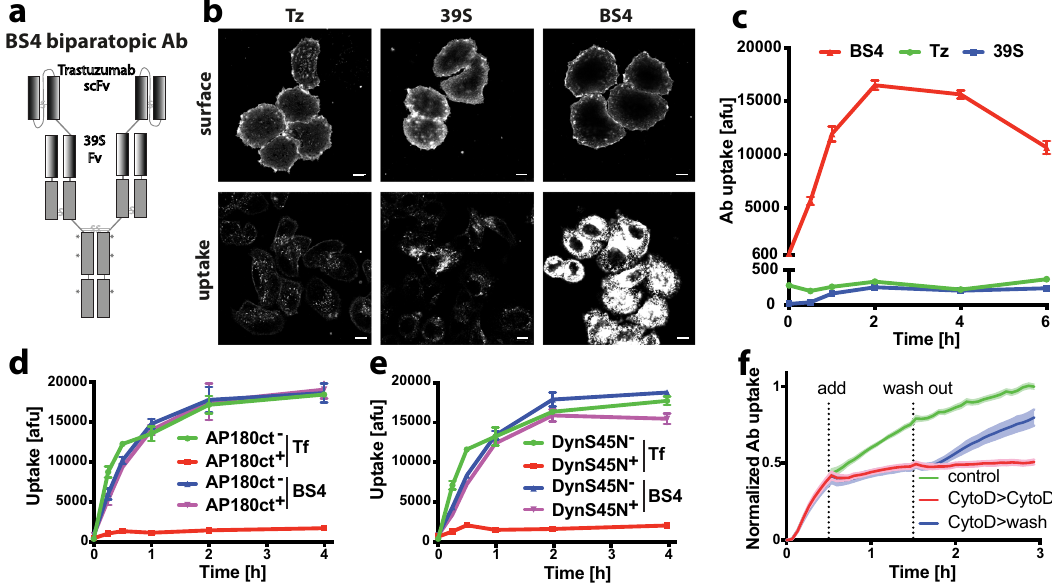
Fig.1|EndocytosisofHER2-speci fi cbiparatopicantibodyBS4isnotdependent onclathrinanddynaminbutrequiresF-actin.a Schematicrepresentationofanti- HER2 biparatopic antibody BS4. The Trastuzumab (Tz) single-chain variable frag- ment(scFv)isattachedtotheNterminusoftheheavychainof39SIgG1resultingin four antigen binding sites per molecule. Mutations in the Fc region (*) reduce binding to Fc gamma receptor. b , c Surface binding and endocytosis of dylight650- labelled monotopic antibodies Tz and 39S and biparatopic BS4 (all at 3 µ g/ml) after 1hofuptakebyconfocalmicroscopy( b )andoveraperiodof6hby fl owcytometry ( c ), (means±SD, n =3 independent experiments). d , e Endocytosis of BS4 is inde- pendent of clathrin and dynamin. SkBr3 cells transfected with dominant-negative